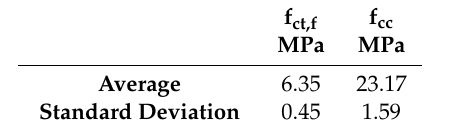
Table 1. Mechanical properties of the used mortar.